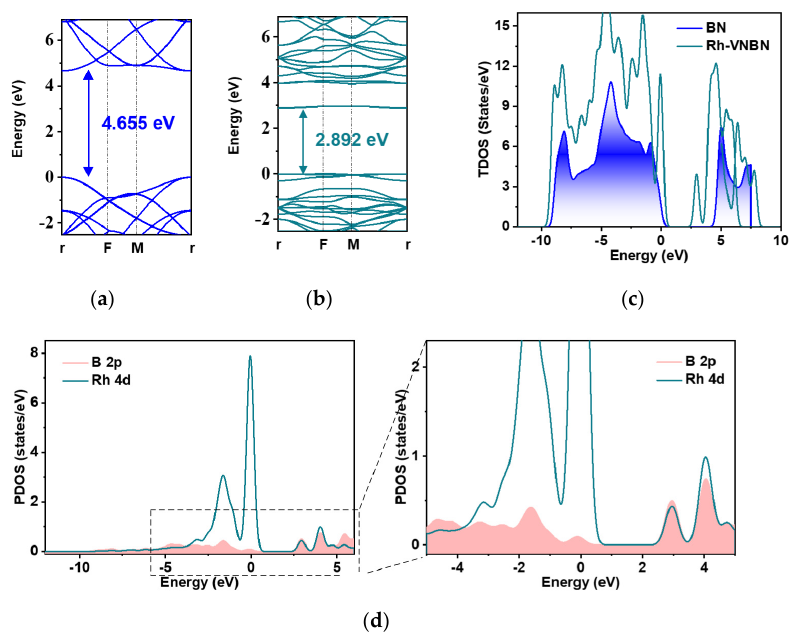
Figure 3. Electronic properties of Rh-VNBN: ( a ) band structure of pure BN; ( b ) band structure of Rh-VNBN; ( c ) TDOS analysis of BN vs. Rh-VNBN; ( d ) PDOS analysis of Rh-VNBN.